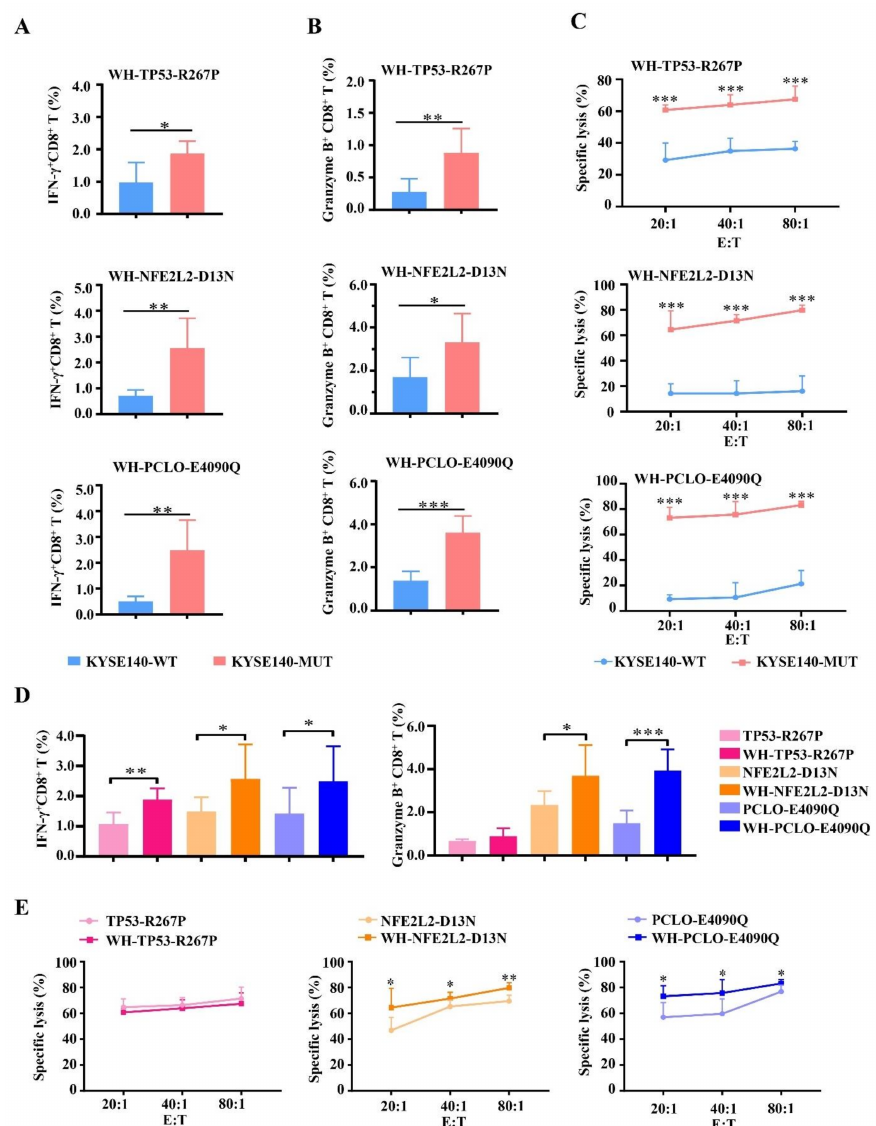
Figure 4. Enhanced MUT peptide-specific and HLA-A2-restricted CTL responses in HLA-A2.1/K